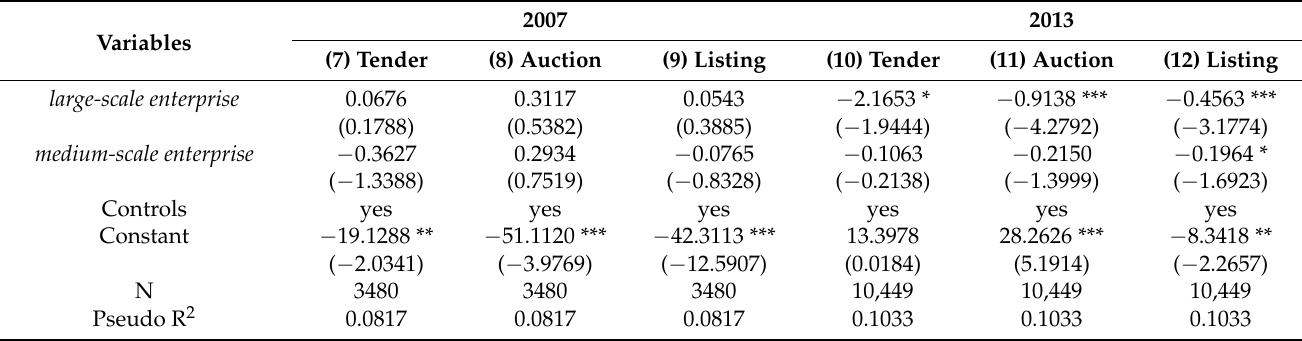
Table 6. Results of mlogit model considering scale of